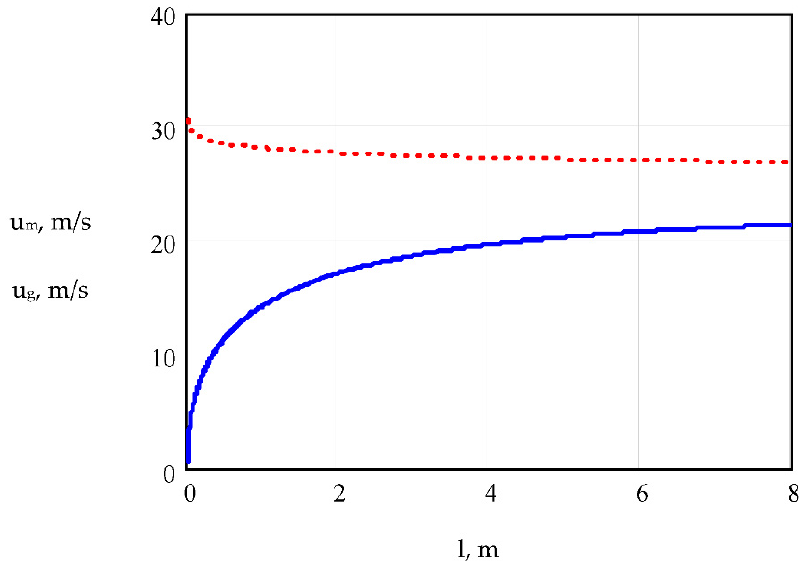
Figure 14. Steam velocity (dotted line) and tobacco velocity (solid line) in the function of the apparatus length. Table 3. Results for a superheated steam pneumatic dryer of tobacco.